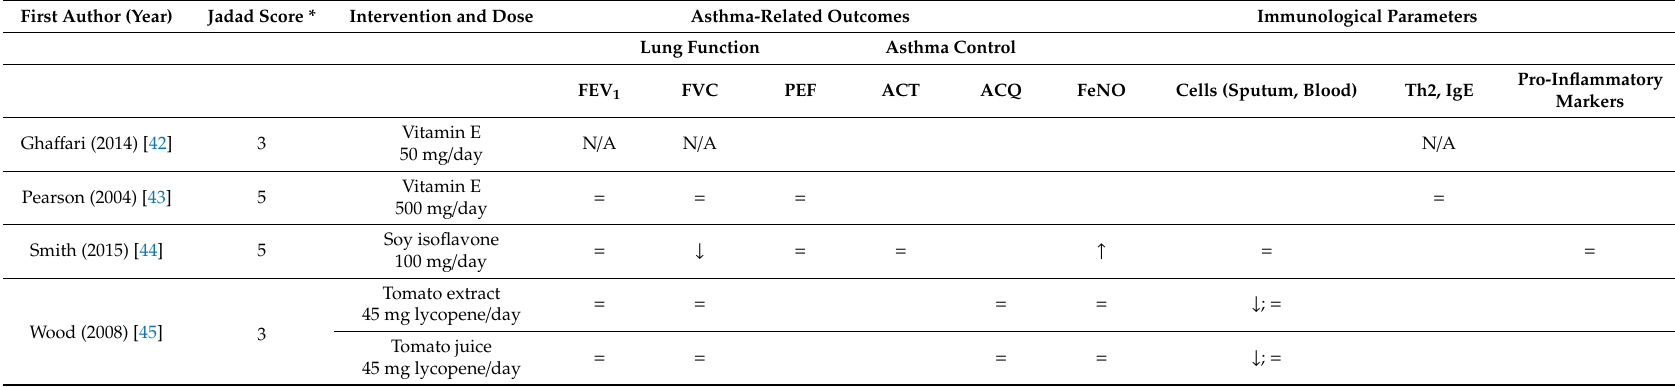
Table 3. Changes in asthma-related outcomes and immunological parameters as compared to the control group for the supplements